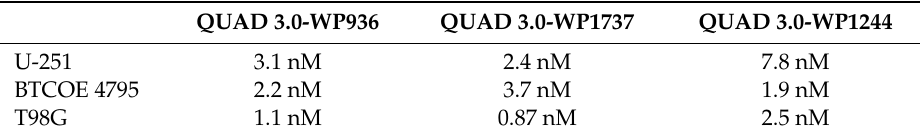
Table 2. The IC 50 values for QUAD 3.0 conjugates with Dox